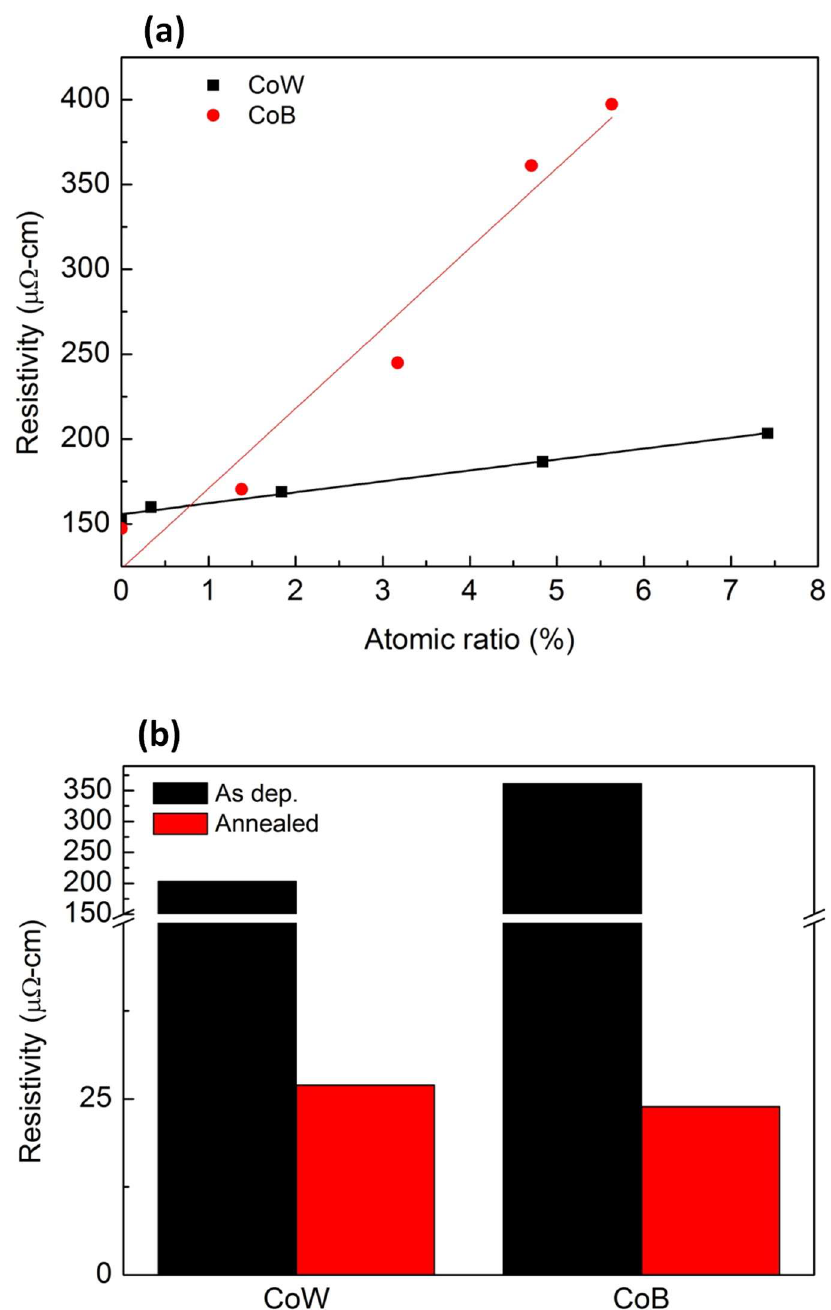
Figure 1. ( a ) Resistivity of CoW and CoB films as a function of alloying-element concentration; ( b ) resistivity changes in CoW and CoB films after annealing at 425 °C.